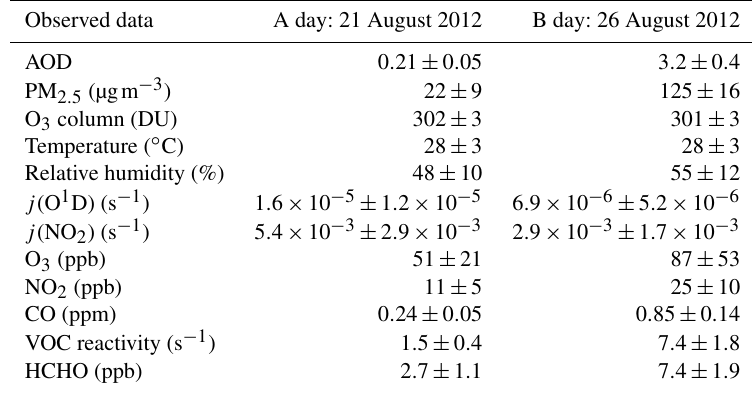
Table 7. Mean and standard deviation of observed data during daytime (06:00–18:00) for A day and B day.